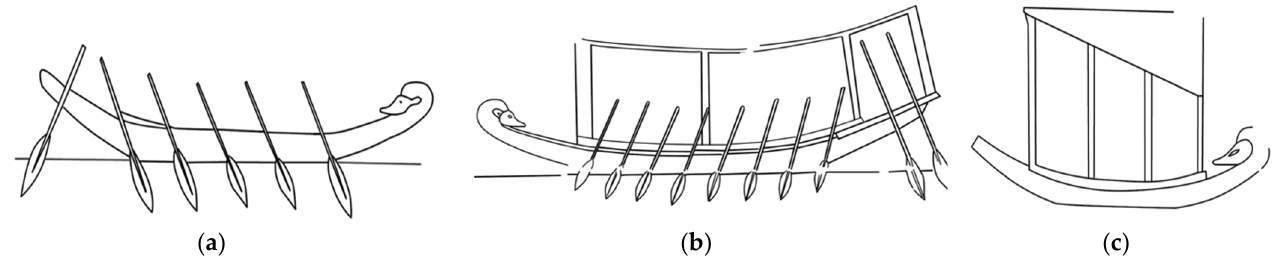
Figure 6. Examples of boats with hedgehog-head prow in the tomb of Niankhkhnum and Khnumhotep at Saqqara ( a ) Redrawn by author after Moussa and Altenmüller (1977, pl. 8). ( b ) Redrawn by author after Moussa and Altenmüller (1977, abb. 11, pl. 30). ( c ) Redrawn by author after Moussa and Altenmüller (1977, abb. 14).